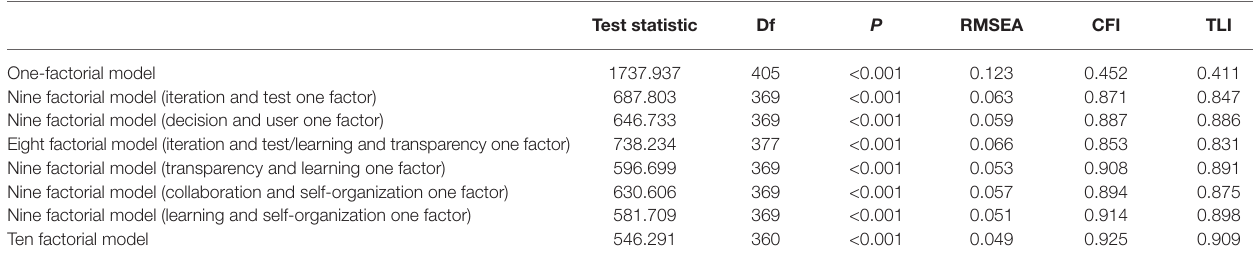
TABLE 3 | Results confirmatory factor analysis sample 1.